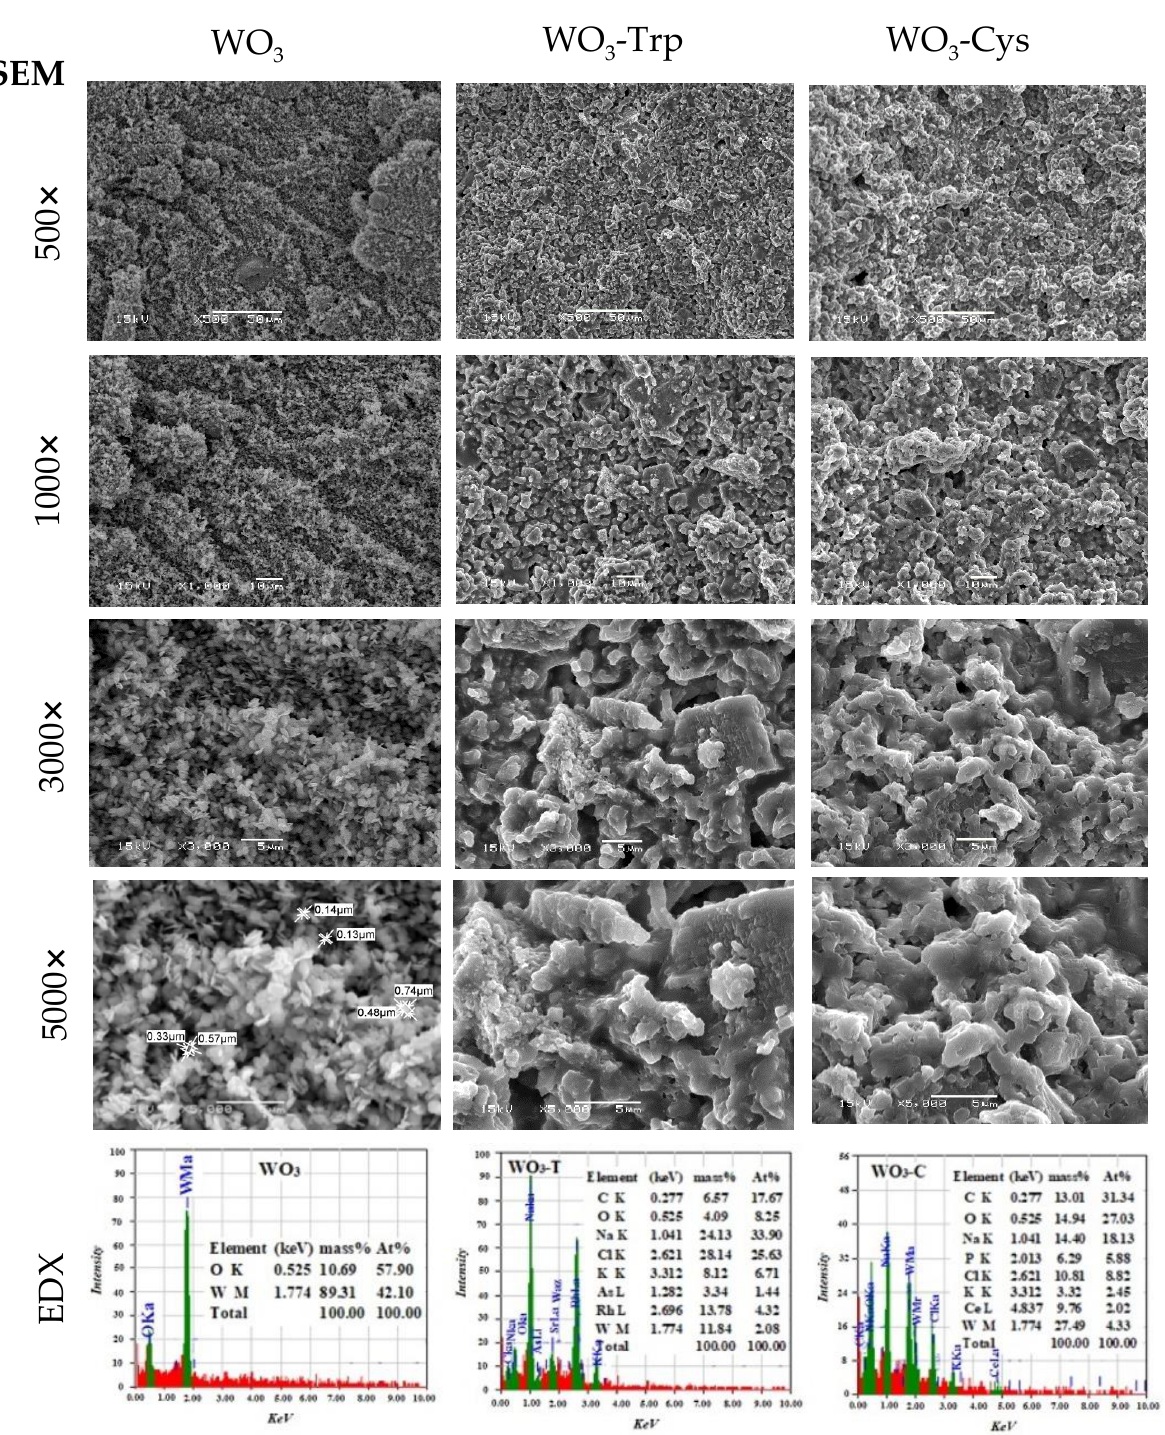
Figure 2. SEM and EDX analysis for prepared WO 3 NPs (column 1), WO 3 -Trp (column 2) and WO 3 -Cys (column 3) at different magnifications (Element: W, O, C, Na, Cl, K, As, Rh, P, Ce; Shell: K, L, M; Mass%: Mass percent of the element in the materials; At%: Atomic percent of the element in the